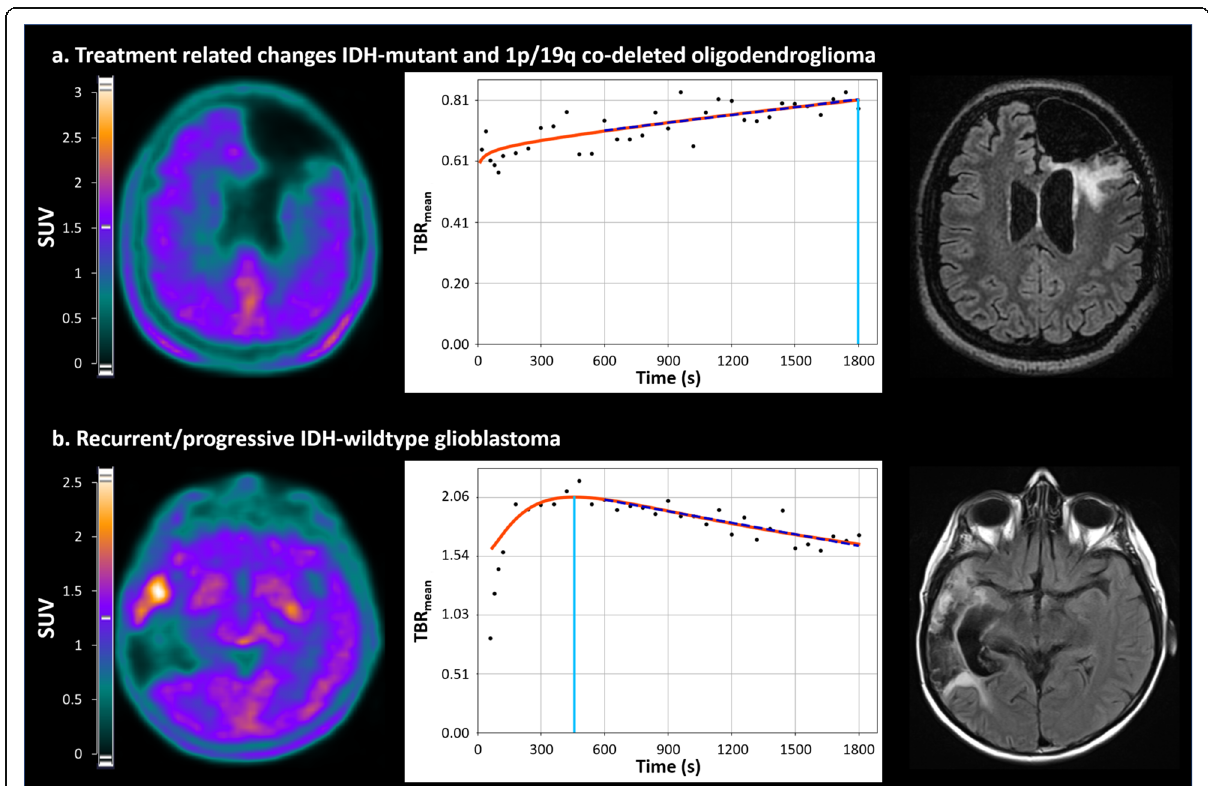
Fig. 3 Representative examples of patients with or without glioma recurrence/progression investigated with [ 18 F]-F-DOPA PET imaging, with axial slices of [ 18 F]-F-DOPA PET (left column), dynamic TBR mean curves (middle column) providing the time-to-peak delay-time (light blue dotted line), and the 10-to-30 min slope (dark blue dotted line), along with, for illustrative purposes, the same slice location recorded on a FLAIR MRI sequence (right column). a 51-year-old woman with no recurrent or progressive glioma (TBR mean = 0.8, TBR max = 1.1, TSR mean = 0.5, TSR max = 0.7, MTV = 0 mL, TTP = 30 min, and slope = 0.31 h − 1 ). b 46-year-old woman with a progressive IDH-wildtype glioblastoma (TBR mean = 1.9, TBR max = 2.5, TSR mean = 1.2, TSR max = 1.6, MTV = 6.13 mL, TTP = 7.6 min, and slope = − 1.22 h − 1